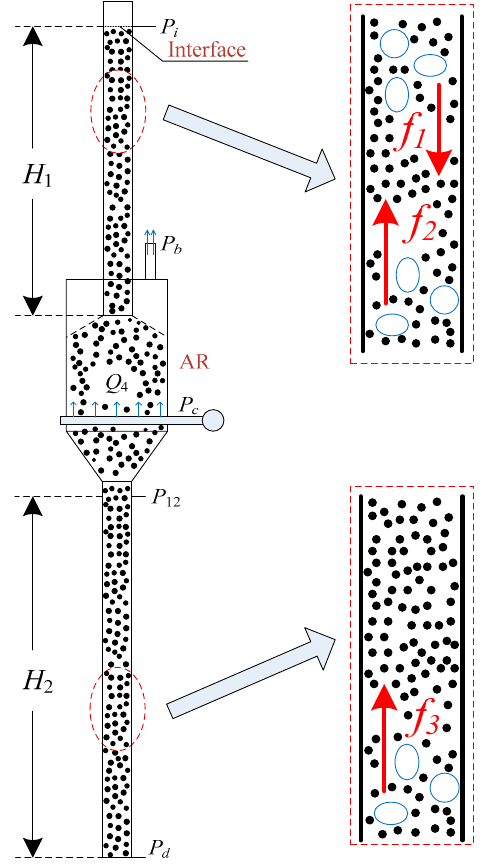
Figure 7. The possible routes of gas leakages in the proposed iG-CLC system.